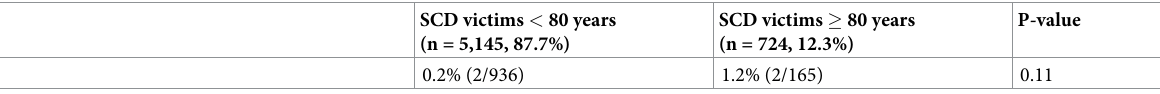
the group aged 80 years or more (93.0% vs. 88.7%, P = 0.05) (Table 3). More than half (62.6%) of the SCD victims aged � 80 years and less than half (40.9%) of those aged < 80 years had a history of CAD prior to SCD (P < .001). Medical history of the SCD victims of the present study is shown in Tables 1–3. Based on autopsy findings, NIHD was a less common etiology of SCDs among those � 80 years than among those < 80 years (Table 1). The proportion of cardiomyopathies as a cause of SCD did not differ statistically significantly between octogenarians and nonagenarians (4.4% vs. 6.1%, P = 0.57) (Table 2) or between males and females among those � 80 years (3.3% vs. 6.1%, P = 0.07) (Table 3). On autopsy, valvular heart disease was a more common finding in SCD victims aged � 80 years than in those aged < 80 years (9.5% vs. 3.4%, P < .001) (Table 1) and in nonagenarian SCD victims than in octogenarian SCD victims (17.1% vs. 8.6%, P = 0.02) (Table 2). The proportion of valvular heart disease did not differ significantly between males and females in SCD victims aged � 80 years (8.0% vs. 11.3%, P = 0.16) (Table 3). The differences in proportions of hypertensive myocardial disease or myocarditis as autopsy findings did not reach statistical significance between SCD victims � 80 years and those < 80 years (3.7% vs. 5.5%, P = 0.051, 0.4% vs. 1.1%, P = 0.08, respectively) (Table 1).